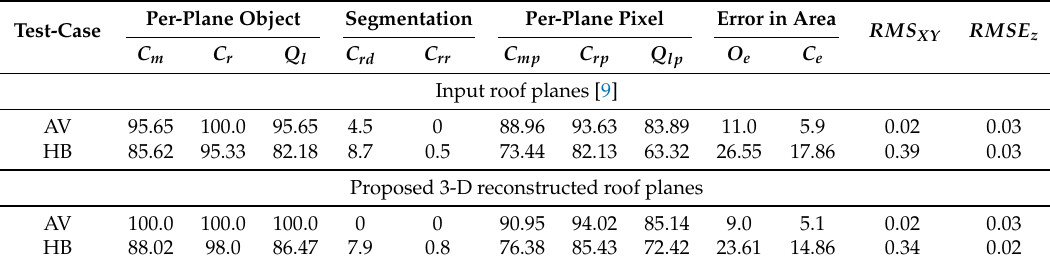
Table 3. Roof planes evaluation results using threshold-free reference classification of Australian datasets. C m , completeness; C r , correctness; Q l , quality in percentage; C mp , pixel completeness; C rp , pixel correctness; Q lp , pixel quality; C rd , detection cross-lap (under-segmentation); C rr , reference cross-lap (over-segmentation) rates; O e , area omission error; C e , area commission error; RMS XY , planimetric accuracy (metres); RMSE z , height accuracy